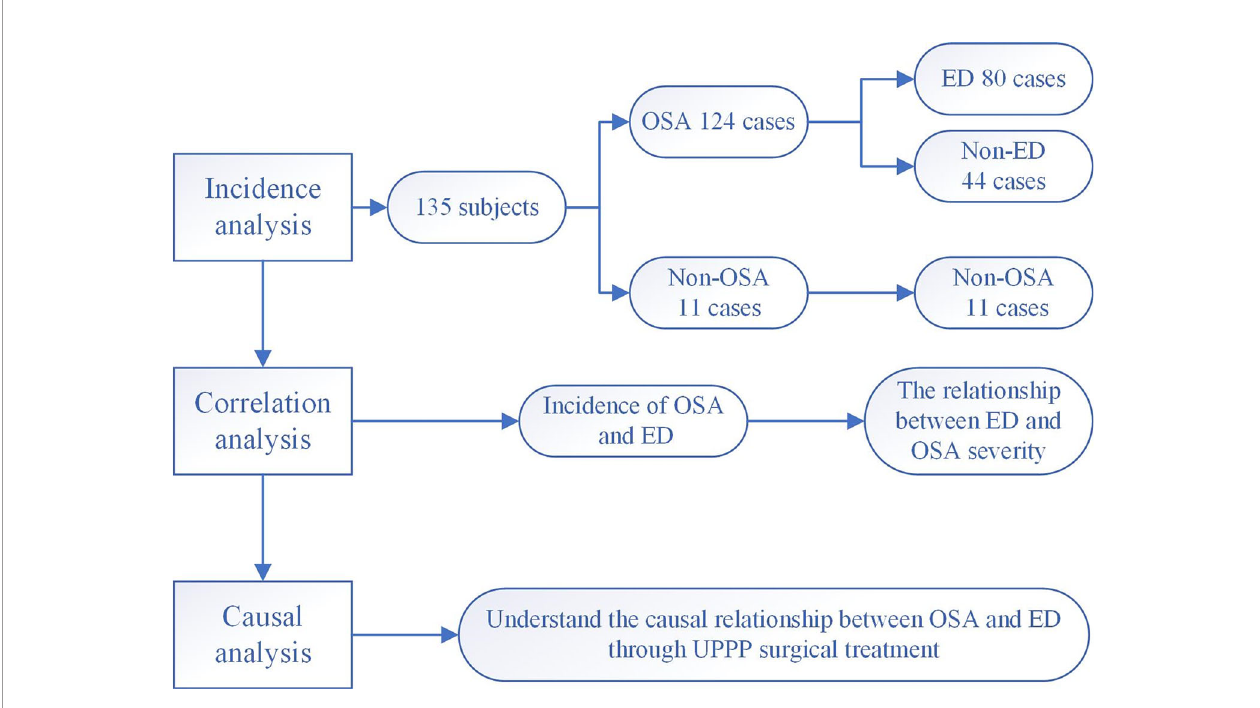
FIGURE 1 | Research fl ow chart. 135 male subjects with relevant clinical data were included to explore the mechanism underlying the comorbidity of OSA and